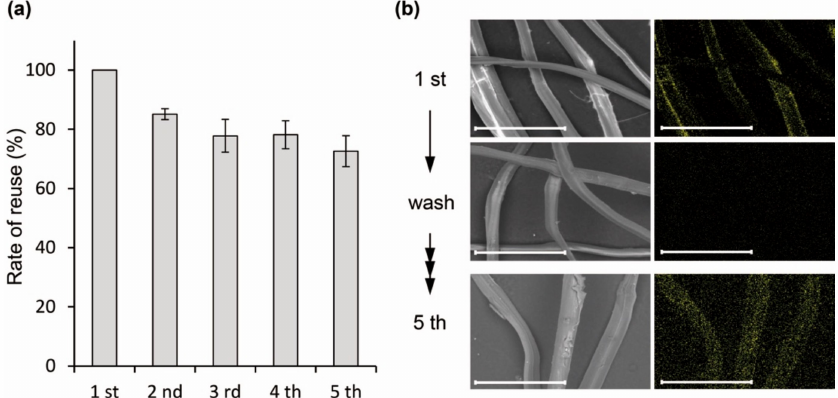
Figure 7. Reusability of silk powder for Dy 3 + recovery. ( a ) The relative degree to the initial Dy 3 + recovery e ffi ciency is shown. Averages and standard deviations for three independent experiments were represented. ( b ) SEM-EDX analysis, the captured Dy (yellow signal) was eluted with acetic bu ff er (50 mM) at pH 4.0, and the silk powder was recycled. Scale bars: 100 µ